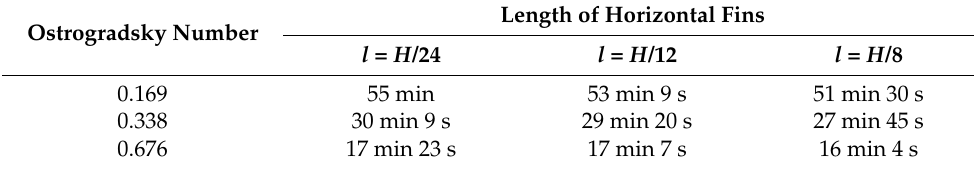
Table 2. Melting time for different Ostrogradsky numbers.